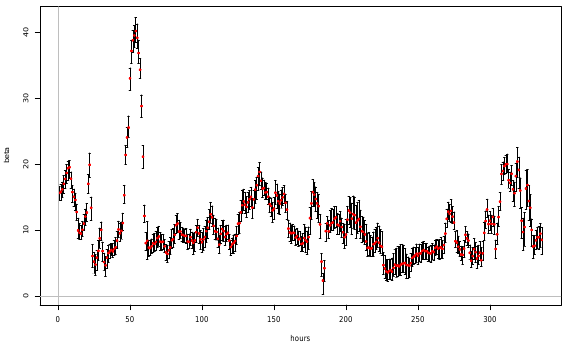
Figure 4 Specifications of PPD42NS Optical sensor (AQICN, 2016)